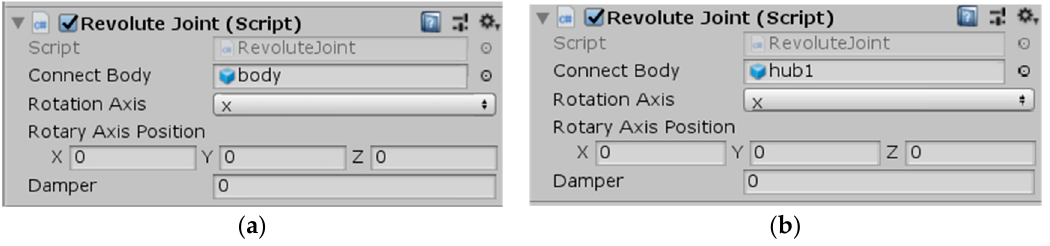
Figure 27. The addition of revolute joint scripts: ( a ) the addition of script to the revolute joint between the body and the hub; ( b ) the addition of script to the revolute joint between the hub and the roller.